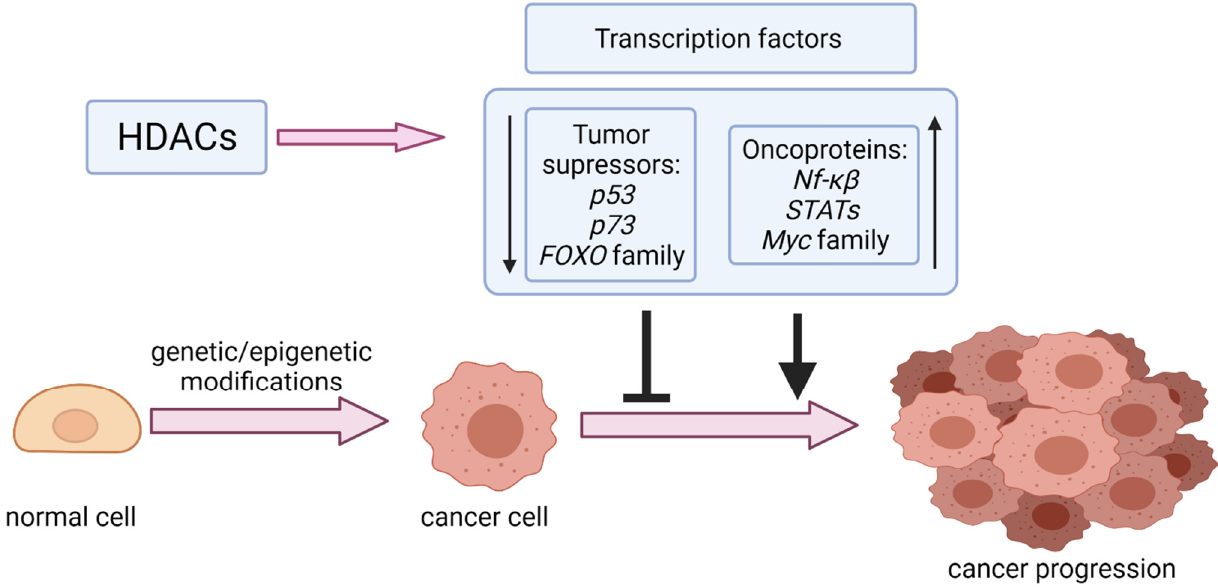
Figure 1. Modulation of transcription factors (tumor suppressors and oncoproteins) by HDACs in cancer progression.